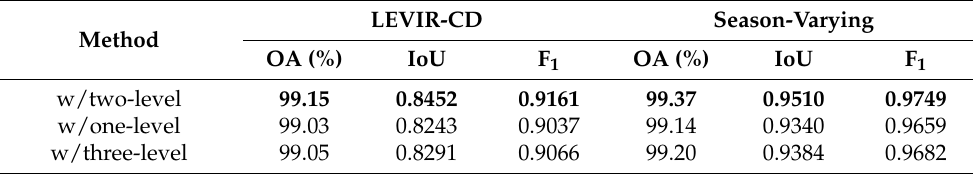
Table 7. Comparisons of the effects of multilevel feature fusion strategies.